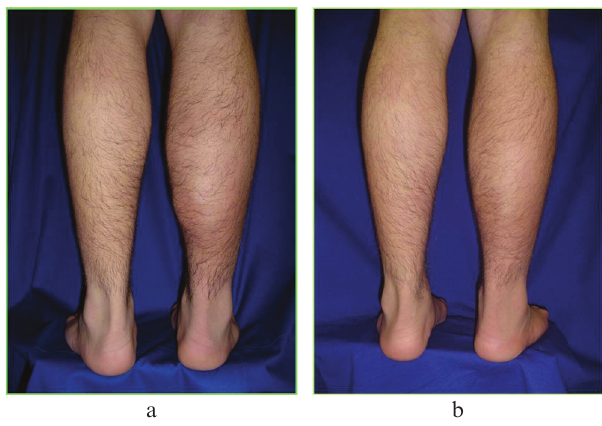
Figure 1 - Muscular lesion before treatment (a) and after